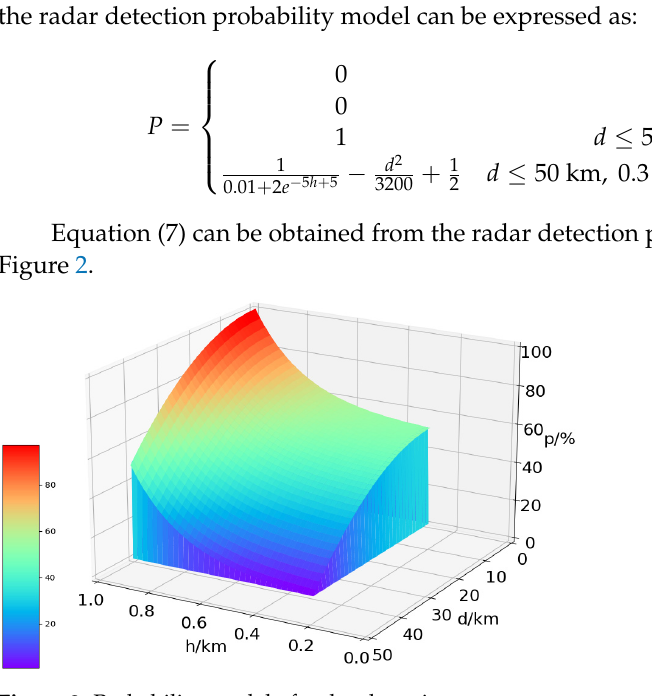
Figure 2. Probability model of radar detection.